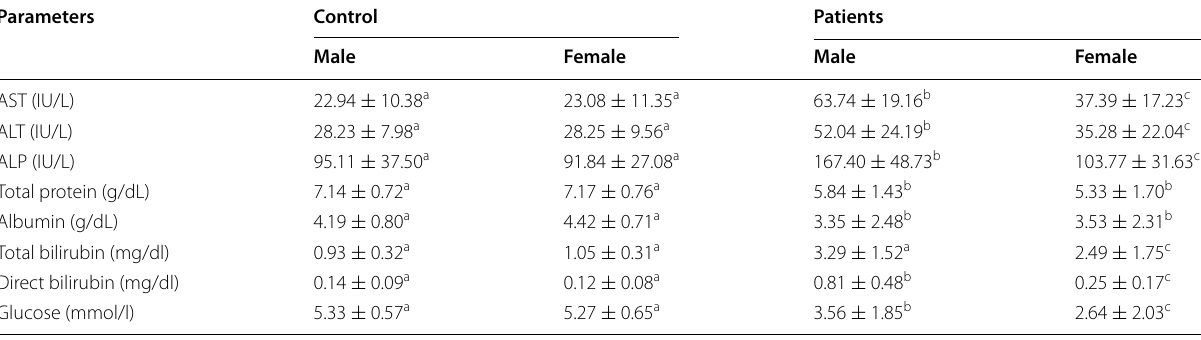
The values are expressed as mean standard deviation of the observations in each group ± Values with different superscript letters in the same row are significantly different from each other ( P <0.05)